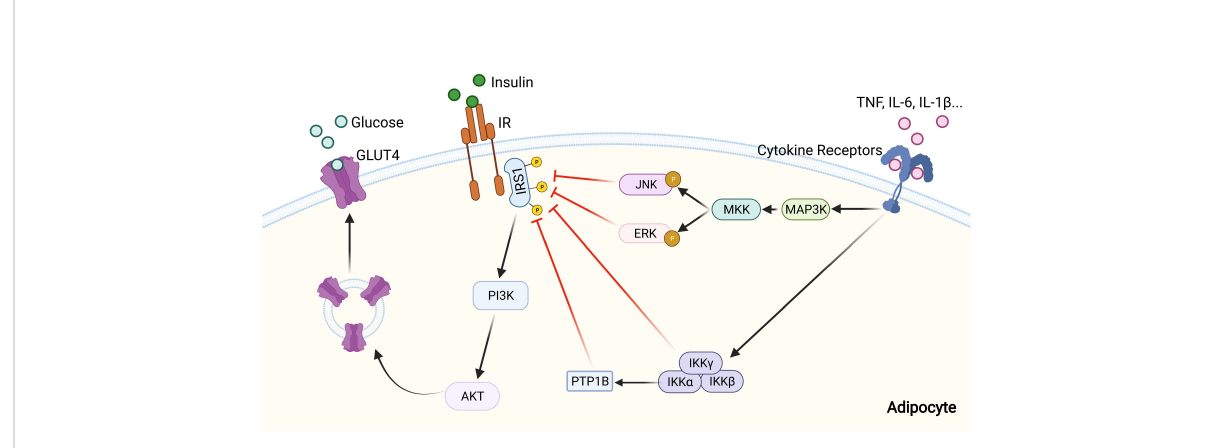
FIGURE 3 Inhibition of insulin signaling pathway by in fl ammatory signaling. Pro-in fl ammatory cytokines, including IL-1 b , IL-6, and TNF, can activate in fl ammatory signaling pathways through their receptors. Then activated MAPK and NF- k B signaling pathways inhibit insulin signaling by altering the phosphorylation status of IRS-1, and further lead to a reduction of glucose uptake by